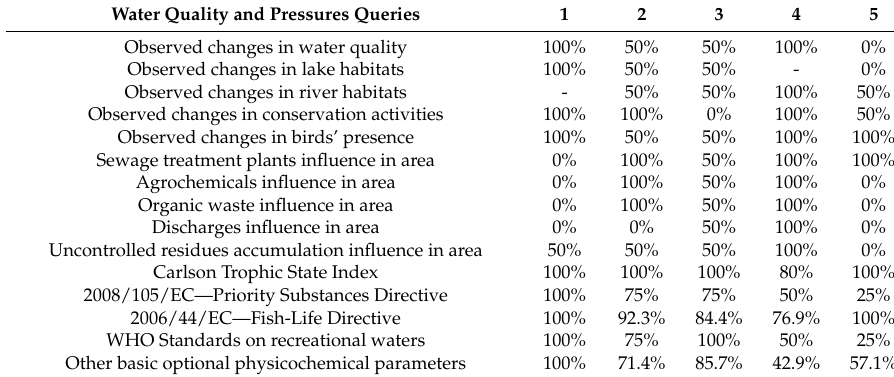
Table 3. Percentages of gap analysis of the five PAs regarding the water quality and pressures. 1: L’ Albufera, 2: Krka, 3: Mincio, 4: Una, 5: Karla.